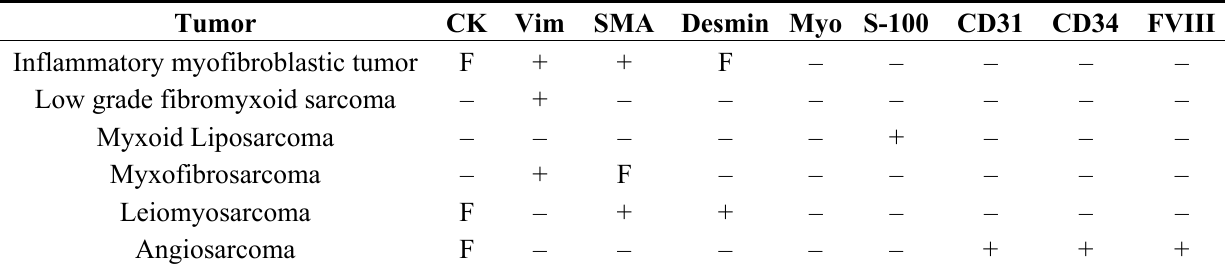
Table 1. Immunohistochemical profile of CM